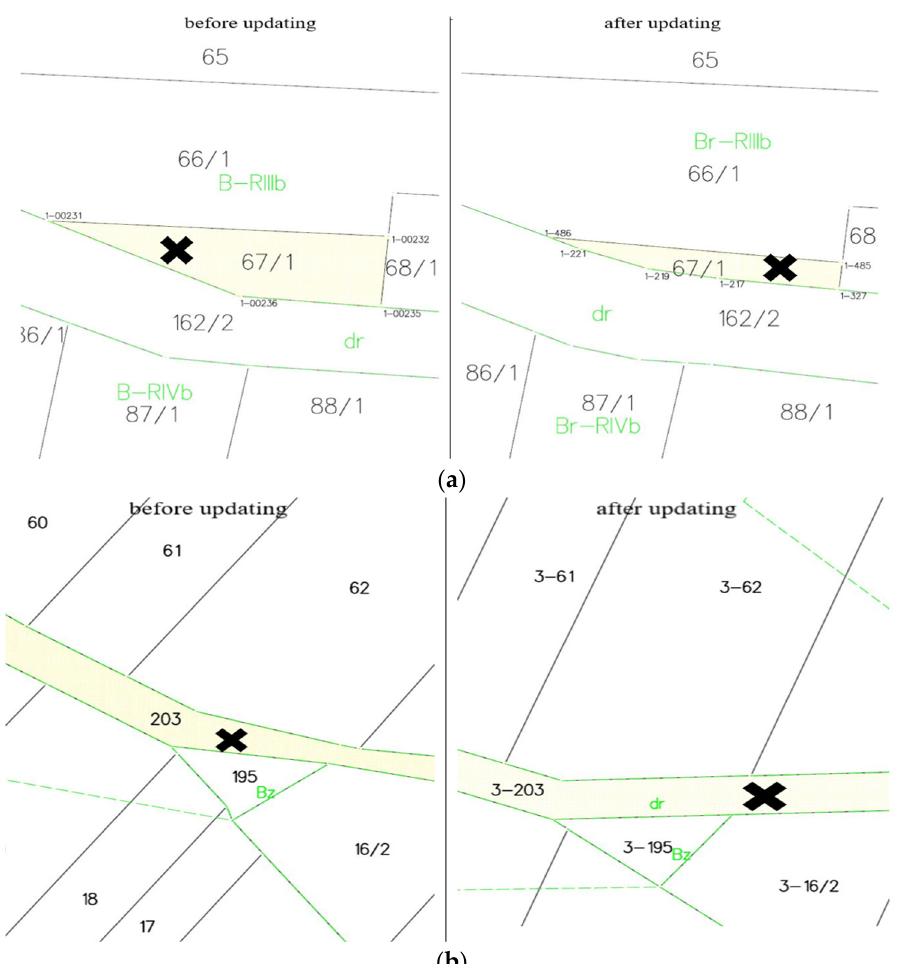
Figure 6. An example of changing borders of dirt road ( a —change of the plot area in the vicinity of a dirt road, b —change of the area of the dirt road). Source: own study.